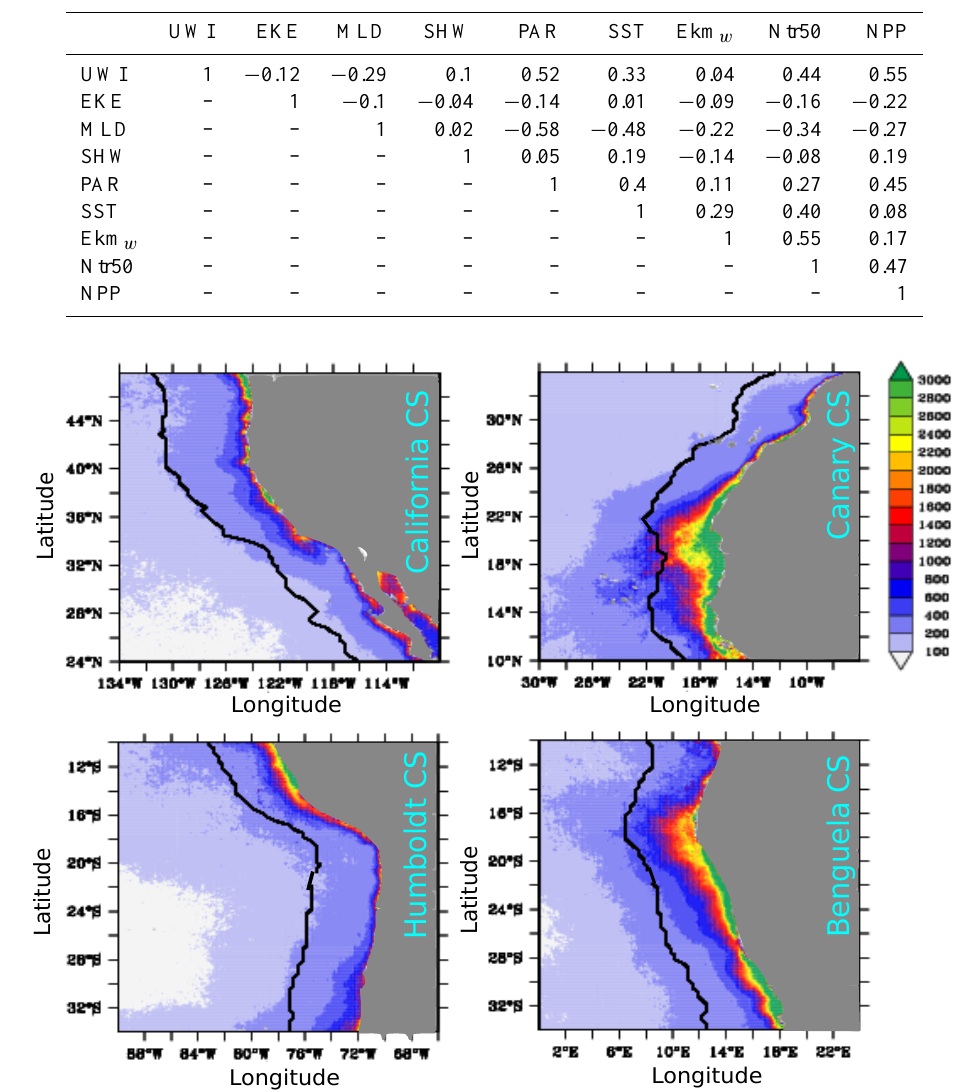
Fig. 1. Annual mean net primary production (NPP) in gCm − 2 yr − 1 for the California, Canary, Humboldt and Benguela systems. The NPP is computed from chlorophyll-a, SST, and PAR using the Vertically Generalized Production Model (VGPM) (Behrenfeld and Falkowski, 1997). The black lines indicate for each EBUS the limits of the 500km offshore coastal band used in this